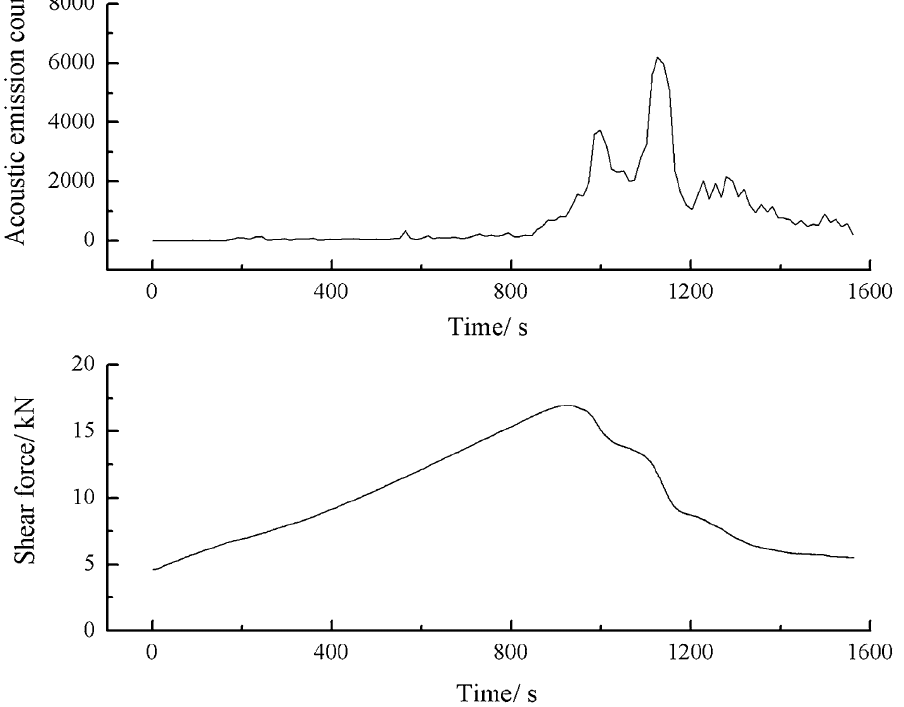
Figure 54. Shear stress–time and count-time curves for a specimen containing 0–0.6 mm and 1–2.56 mm sand particles (two grain size ranges).